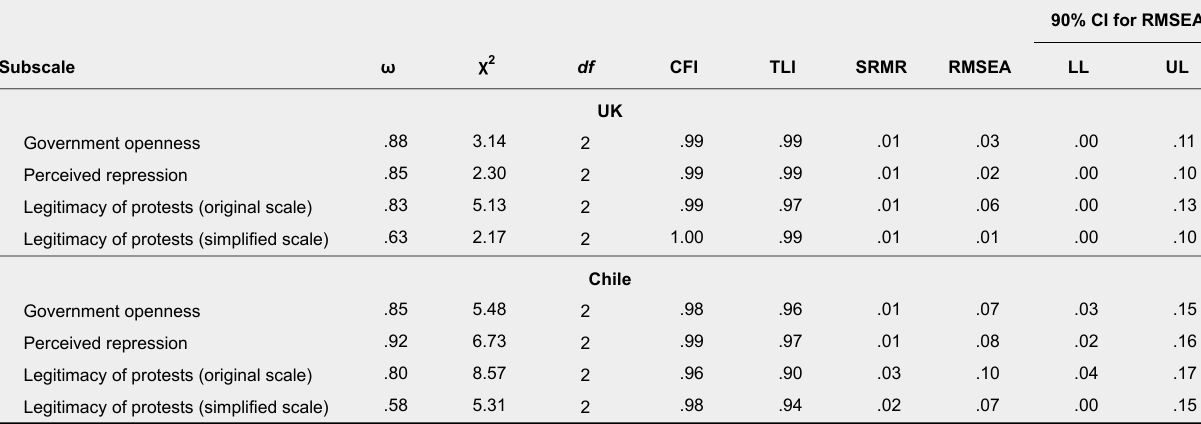
Internal Consistency Reliability Indices and Model Fit Statistics for Each Subscale by